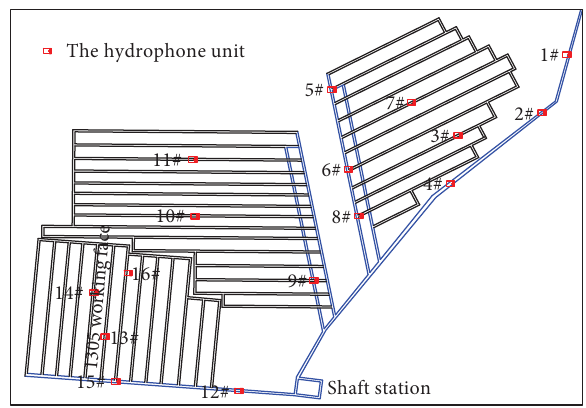
Figure 1: Microseismic monitoring station layout.